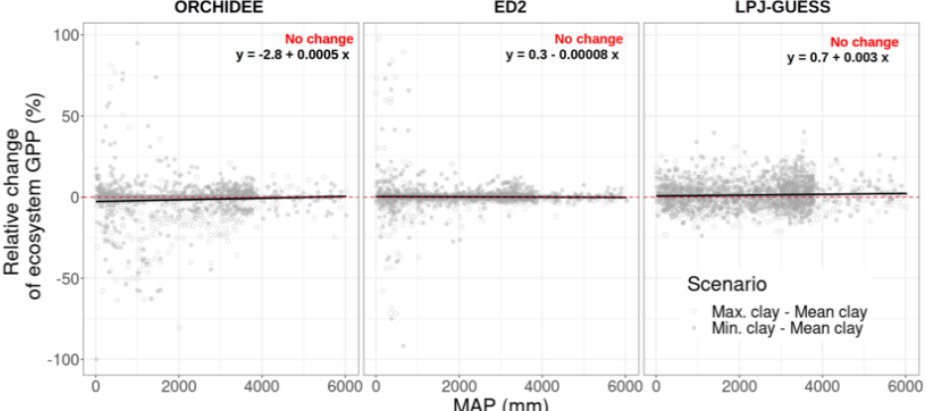
Figure 6. Relative change of the annual ecosystem GPP at the end of the historical simulation with the mean annual precipitation (MAP) for both scenarios (shapes) and all three TBMs considered in this study, across the entire simulated region (each point is a grid cell). The MAP is the annual average over the last 10 years (2006–2016) of the CRU-NCEP dataset forcing. R 2 of all linear models were lower than